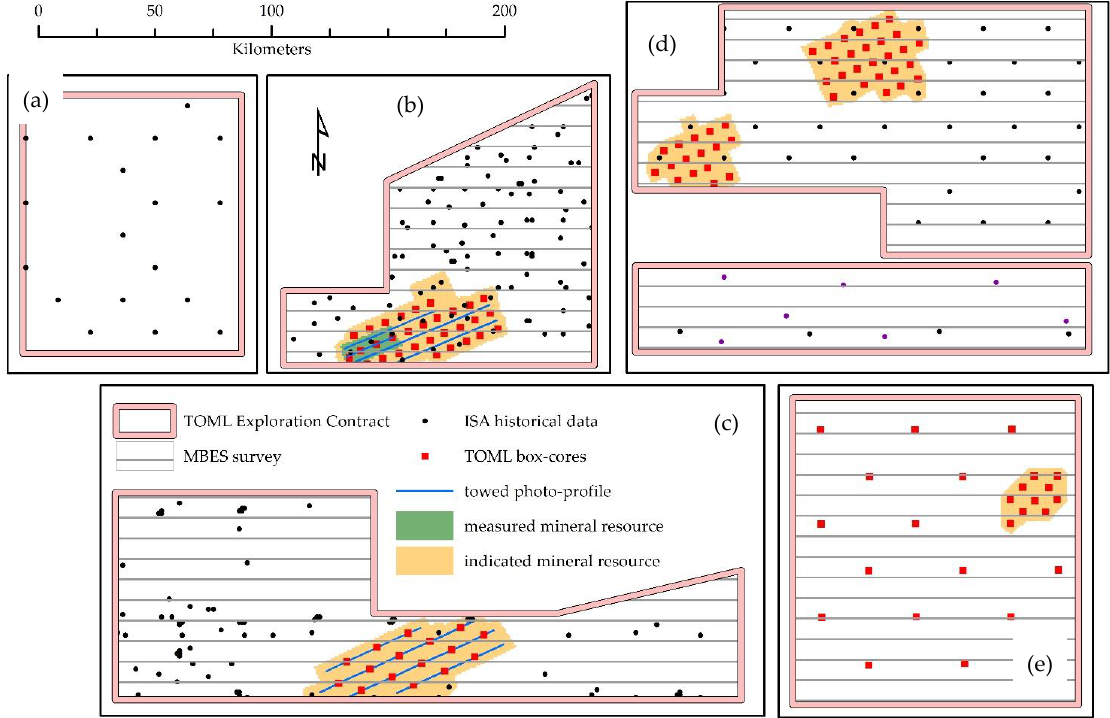
Figure 24. Key data behind the TOML mineral resource estimates. (a) TOML Area A, (b) TOML Area B, (c) TOML Area C, (d) TOML Areas D and E, (e) TOML Area F.